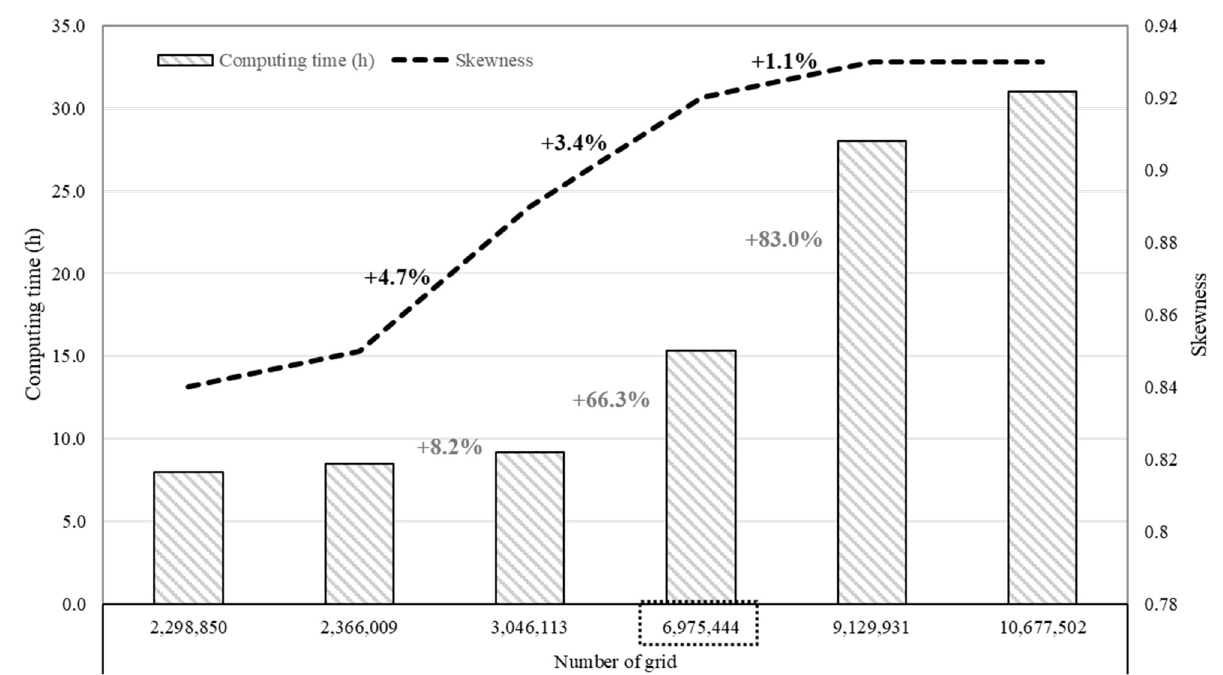
Figure 11. Optimization results according to the total number of grids, skewness, and computing time according to the grid size of the model .